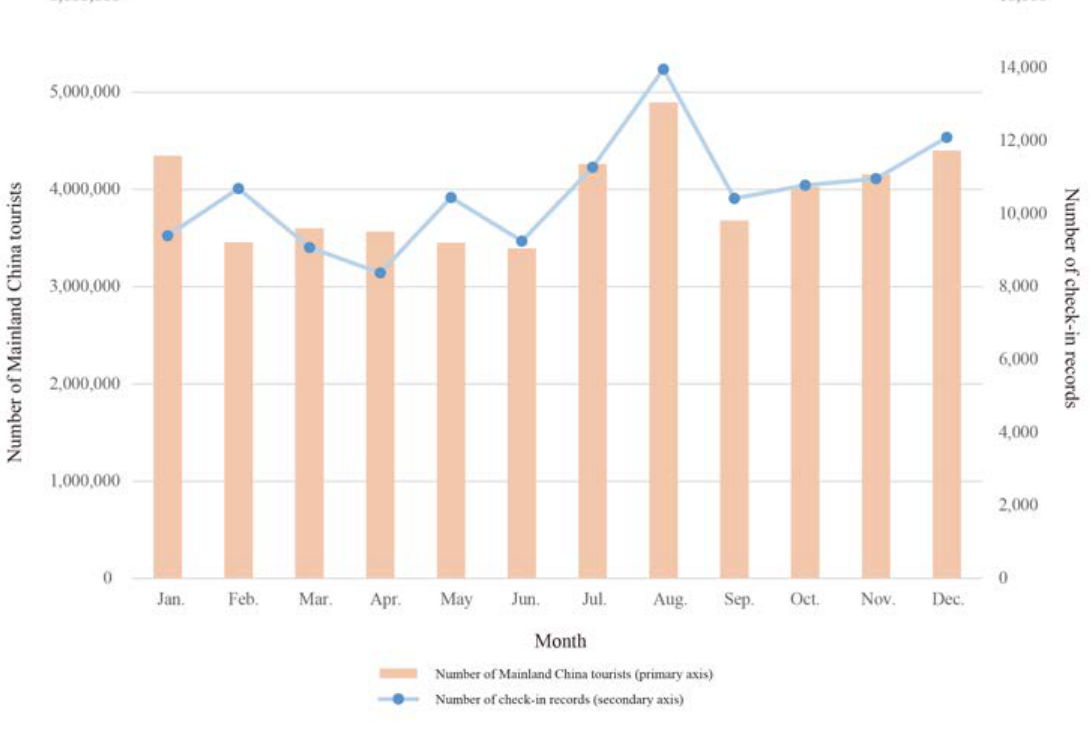
Figure 8. Number of visitors based on check-ins and number of actual